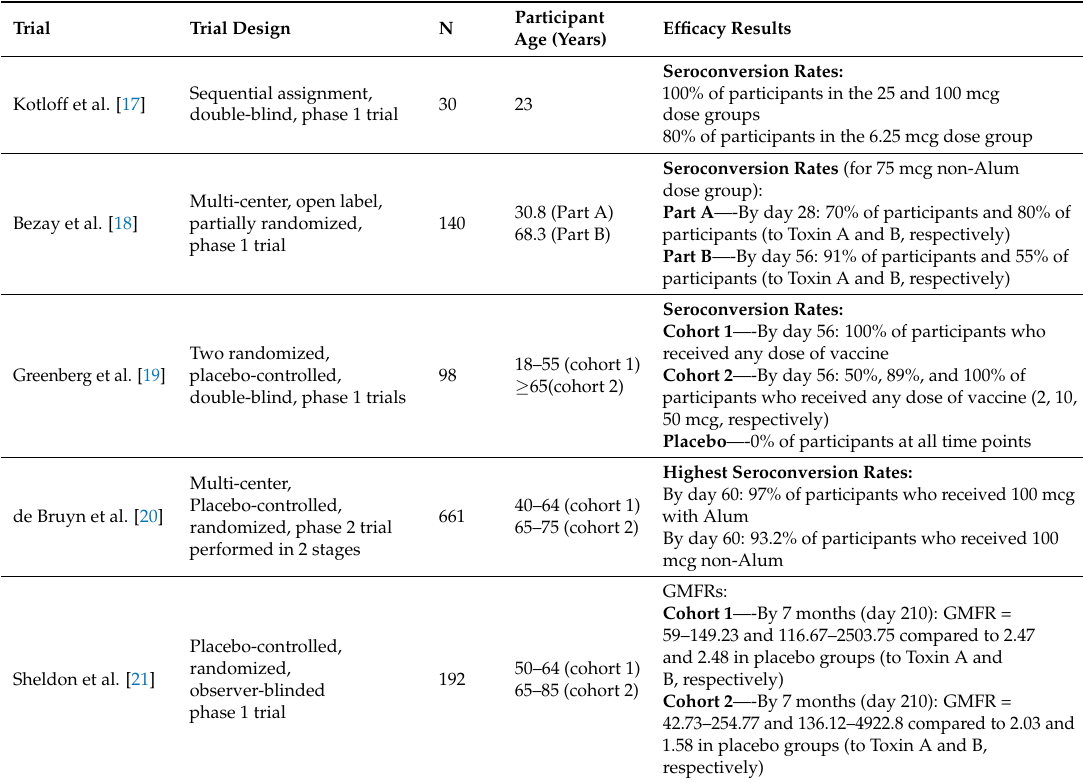
Table 2. Summary of major efficacy